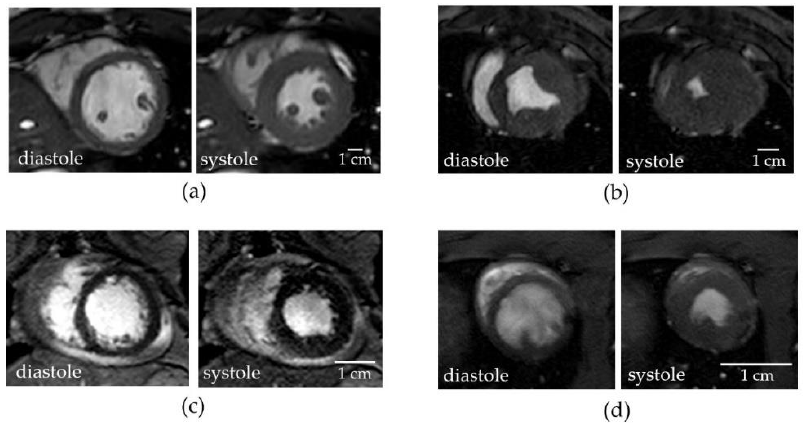
Figure 1. Representative short axis MR images of a human heart, ( a ) and hearts of laboratory animals: pig ( b ), non-human primate ( c ), and rat hearts ( d ), acquired at the end-systolic and end-diastolic